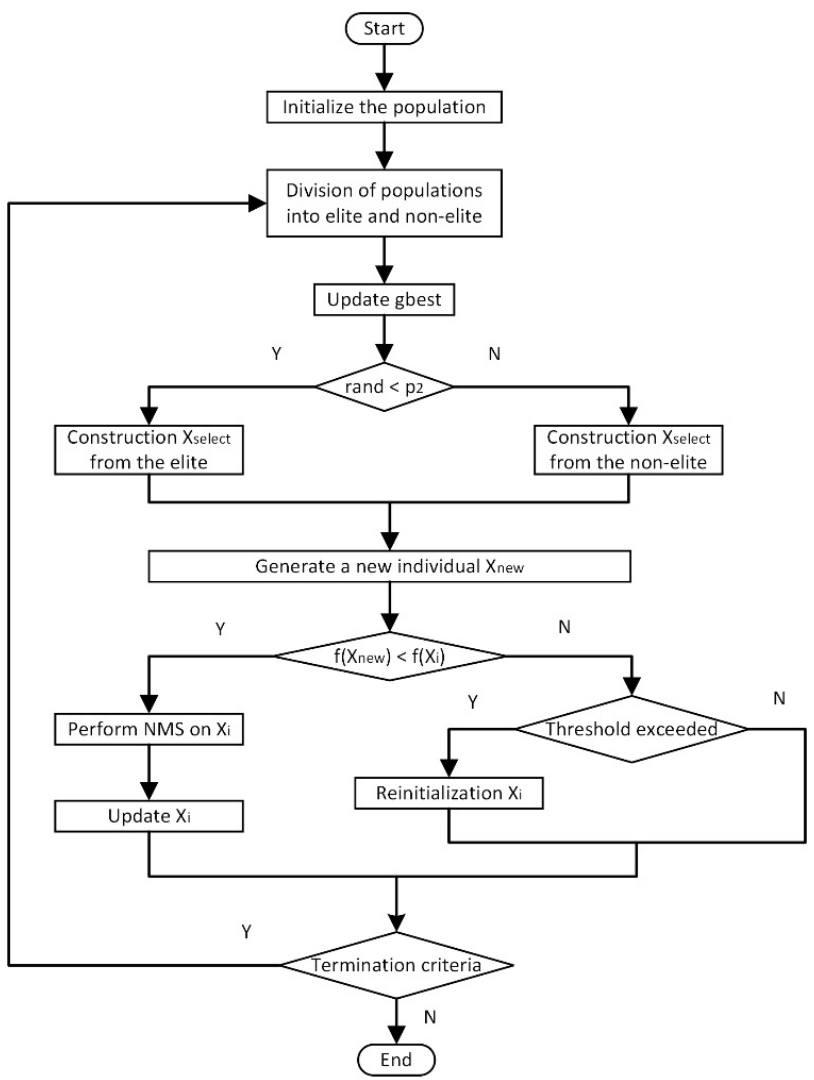
Figure 7. Flow chart of the BSONME algorithm. The pseudo code of BSONME is shown in Algorithm 3. The probability of random disturbance to an individual is denoted as p 1 . The probability of selecting the elite subpop- ulation is denoted as p 2 . The probability of selecting different strategies to generate new individuals is denoted as p 3 . r 1 is a number randomly distributed in the range of [0, 1]. TH denotes the